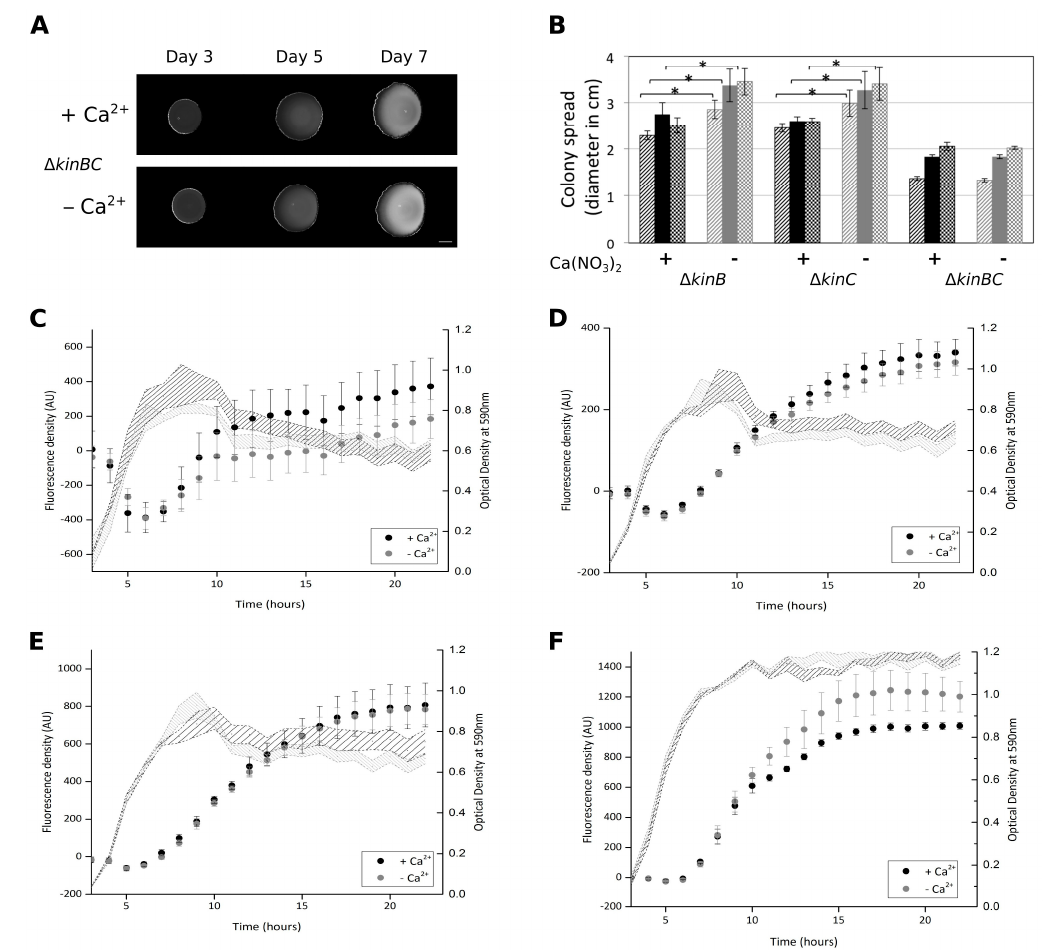
Figure 4. Colony expansion of histidine kinase mutant and expression of selected genes in the presence or absence of Ca 2+ . ( A ) Colony expansion of the ∆ kinB ∆ kinC double mutant after three, five, and seven days. Scale bar indicates 5 mm. ( B ) The colony expansion diameters of the ∆ kinB , ∆ kinC single, and ∆ kinB ∆ kinC double mutant are shown after three (striped), five (filled), and seven (checked) days. Black bars present data in the presence of Ca 2+ , while grey bars indicate the absence of Ca 2+ . The error bars indicate 95% confidence interval. * denotes significant differences ( p < 0.05) analysed with paired t-test. Relative fluorescence and growth profile (optical density) of B. subtilis strains harbouring the P srfAA - yfp ( C ), P epsA - gfp ( D ), P tapA - gfp ( E ), or P bslA - gfp ( F ) constructs in the presence (indicated in black) or the absence (indicated in grey) of Ca 2+ supplemented in the 2 × SG medium.